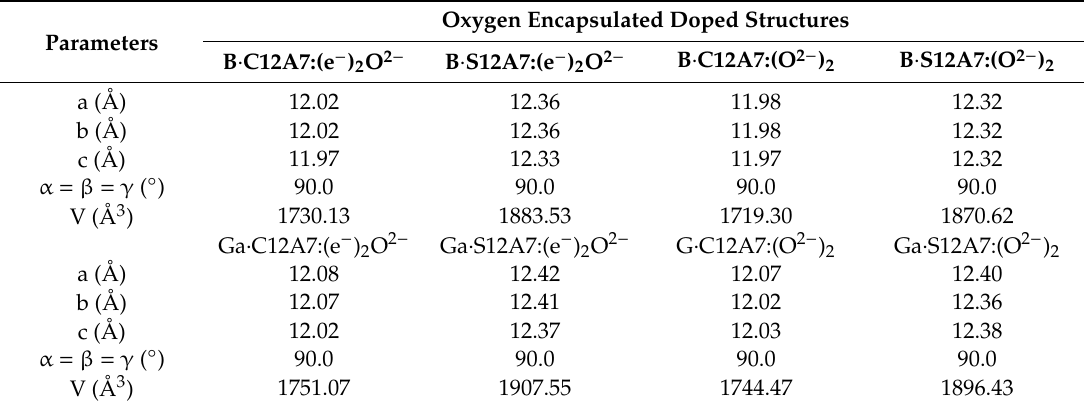
Table 5. Calculated lattice parameters and volumes of oxygen encapsulated doped structures.